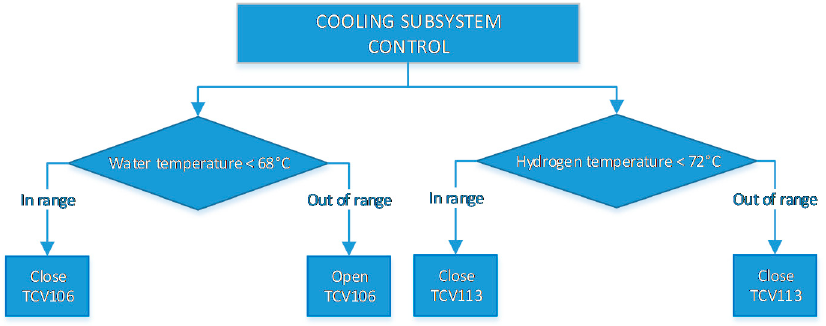
Figure 8. PEM electrolyzer control flow diagram: hydrogen production subsystem.